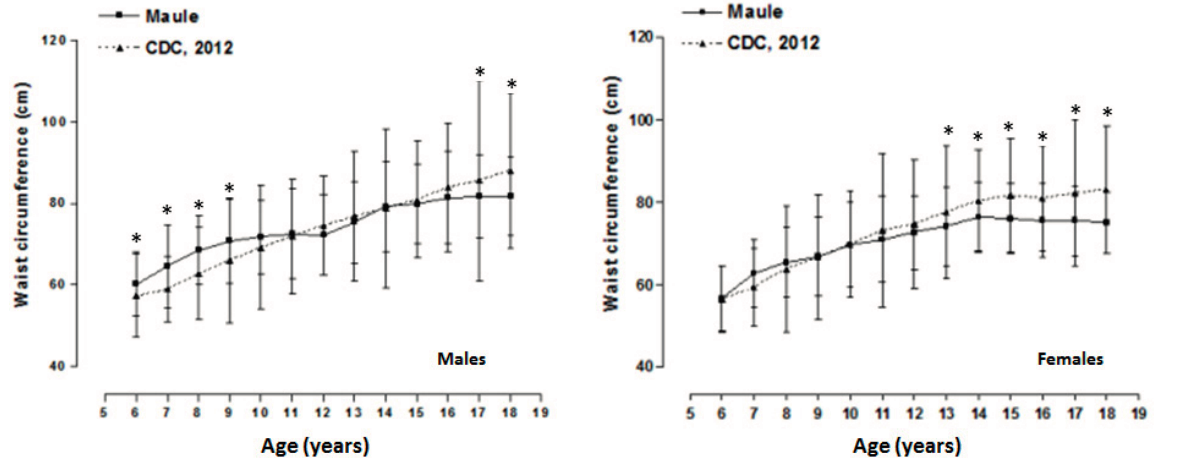
Figure 1. Comparison of averages of waist circumference measurements for the Maule Region (Chile) and the CDC-2012 international index. * Significant difference p < 0.05.